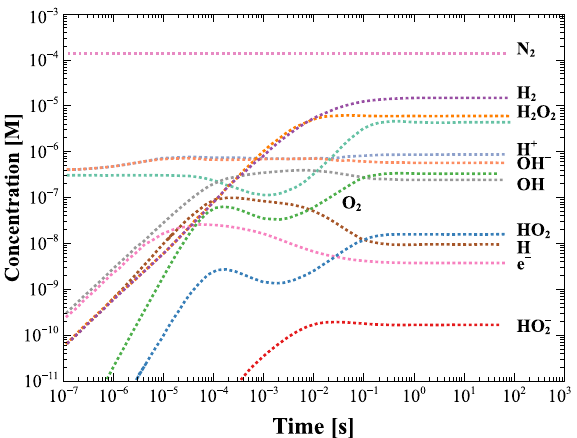
Figure 5. Concentration of radiolysis species in the single module as a function of time with no initial hydrogen addition. Data from